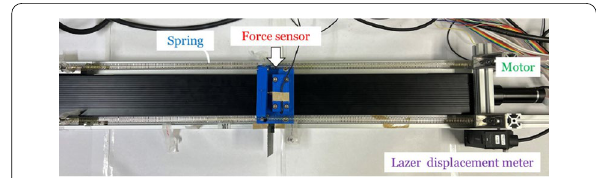
Fig. 7 Picture of an experimental machine with one degree of freedom